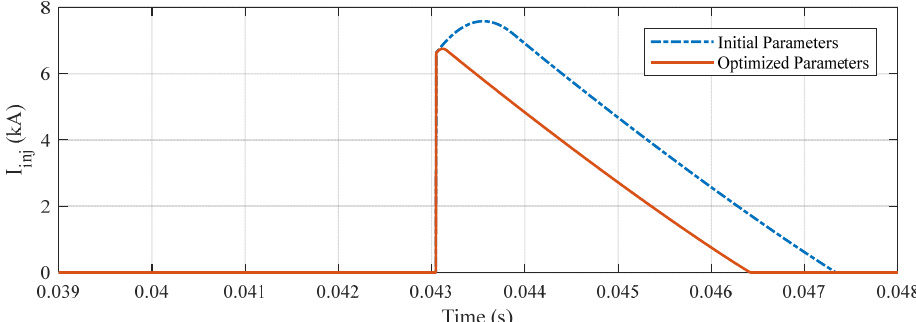
nom in branch 1 of the HCB.